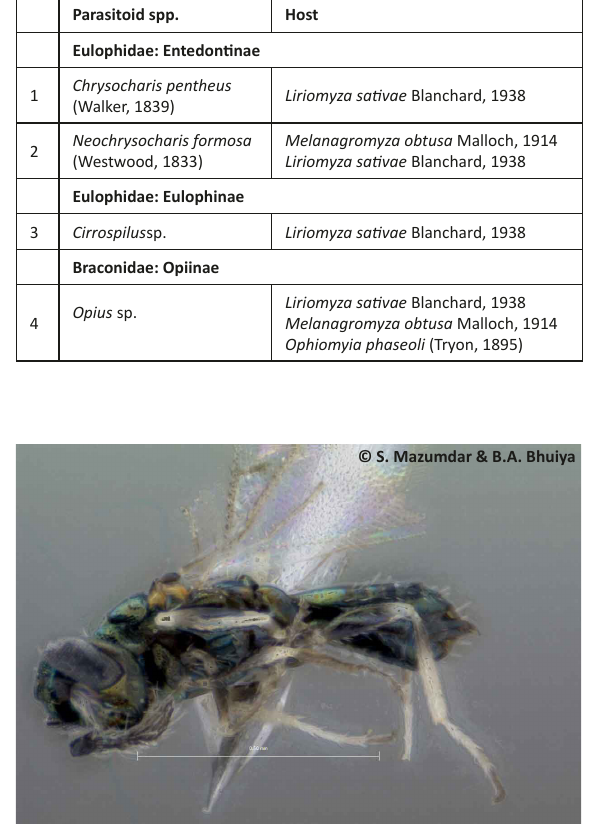
Table 1. List of parasitoids reared from agromyzid leafminers